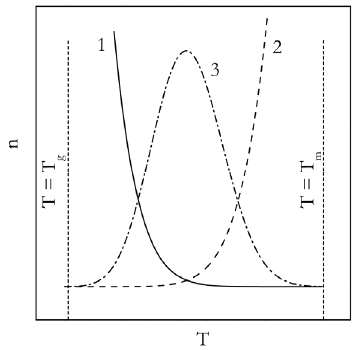
Figure 1. Temperature dependence of the nucleation rate (Equation (8)). 1: exp( − ∆ G * / RT); 2: exp( − E D / RT); 3: product of 1 and 2. Adapted with permission from Vyazovkin [33]. Copyright Elsevier 2008.